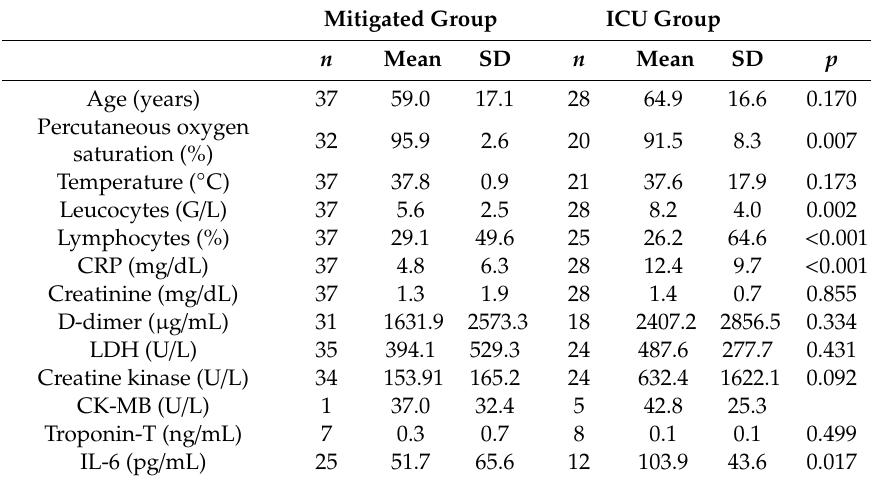
Table 1. Descriptive statistics of the clinical and laboratory parameters. Parameters were compared between the two groups with student’s t